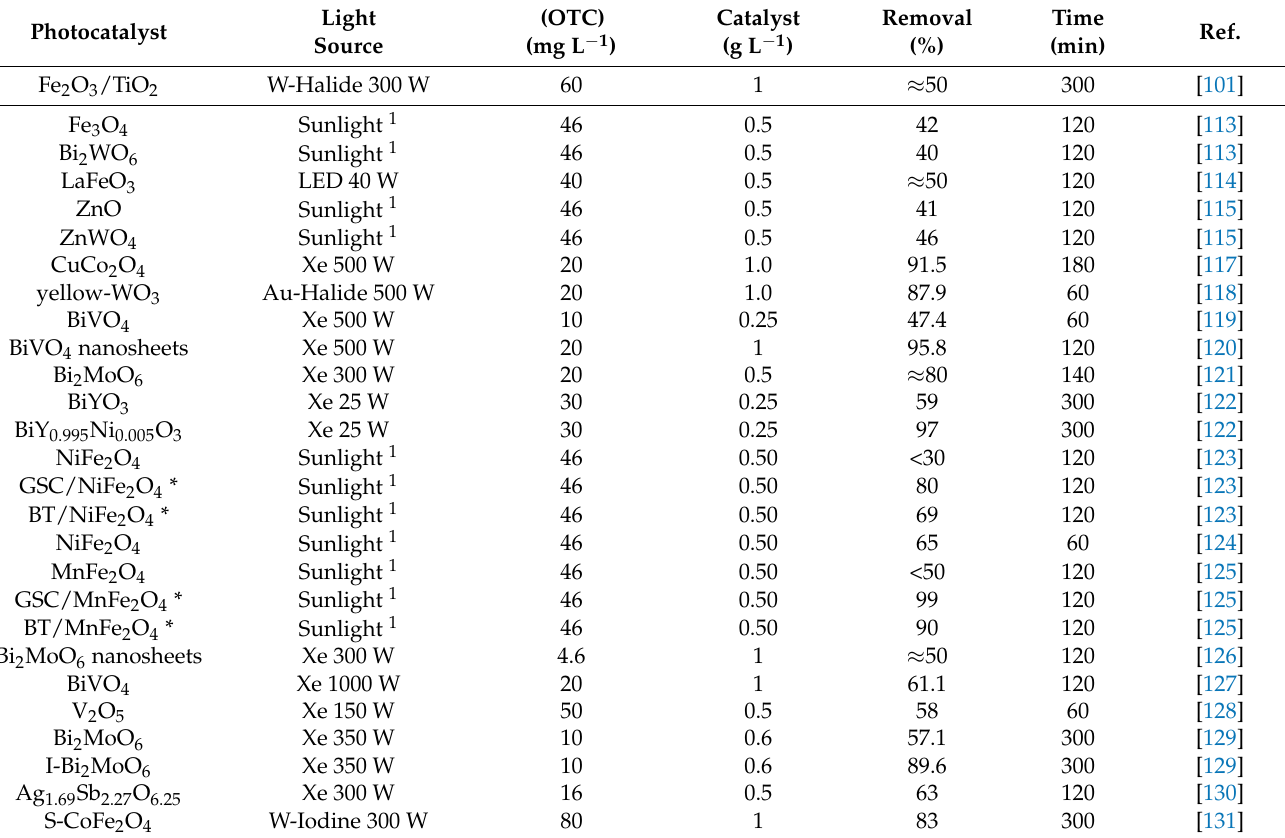
Table 3. OTC photodegradation over semiconductor